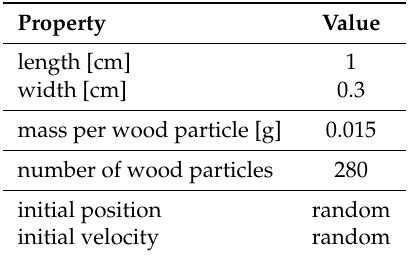
Table 4. Properties of wood particles for scenario 1.